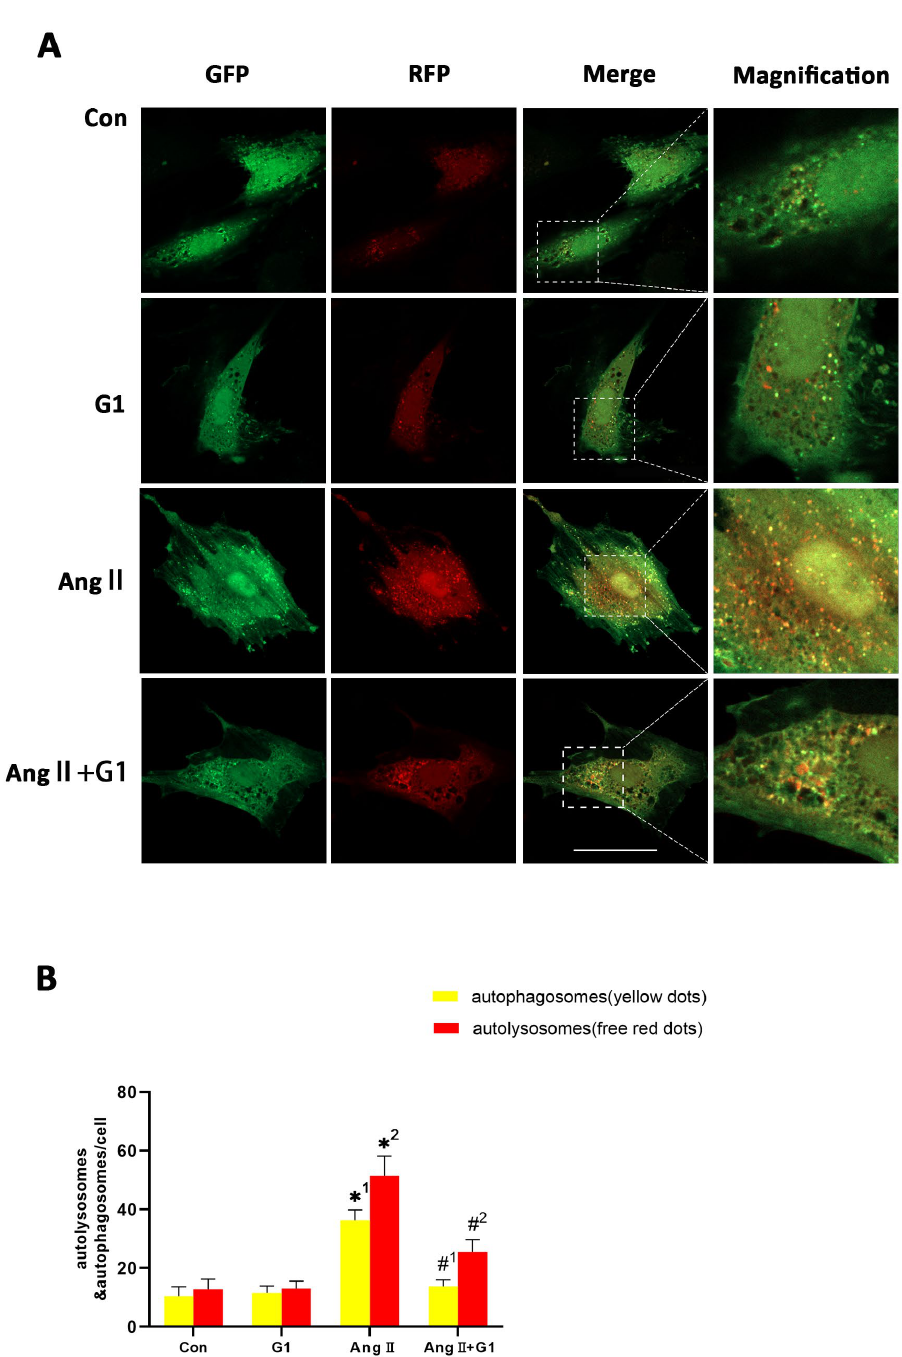
Figure 8. G1 decreased the autophagic flux of H9c2 cells enhanced by AngII. ( A ) Representative confocal microscopy images of LC3 puncta, GFP dots, mRFP dots, and their merged images. ( B ) Mean numbers of autophagosomes (yellow dots) and autolysosomes (free red dots) per cell. The data is expressed as mean ± SEM and was analyzed by one-way ANOVA (n = 4). *1: versus Con group (yellow/APs dots/cell); *2: versus Con group (free red/ALs dots/cell); #1: versus AngII group (yellow/APs dots/cell); #2: versus AngII group (free red/ALs dots/cell). Scale bar = 50 µm.